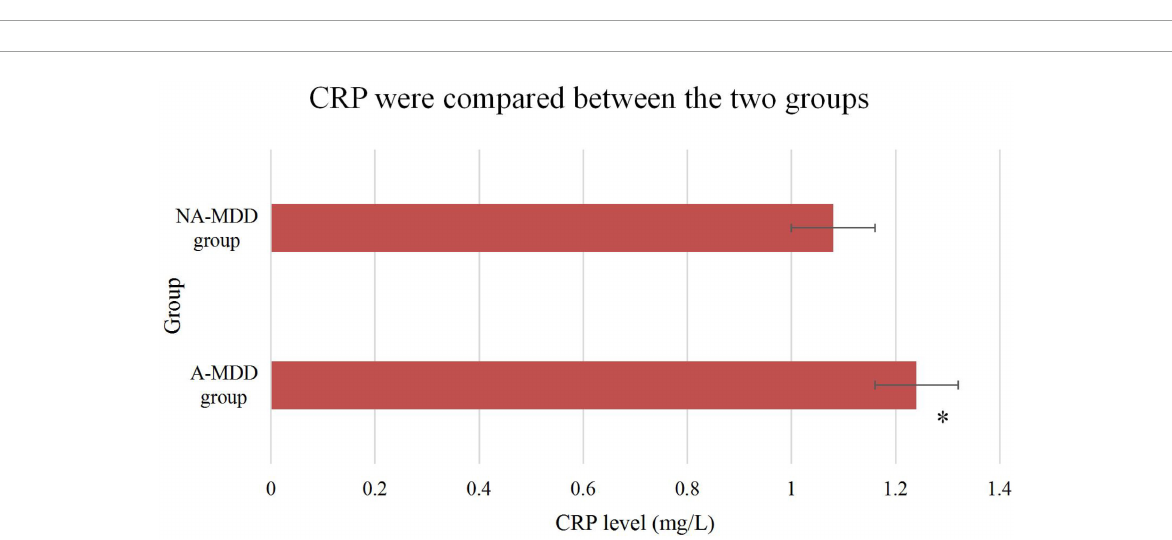
FIGURE7 Comparison of ACTH and cortisol rhythms. ∗ Meant P < 0.05 in contrast to the NA-MDD group.